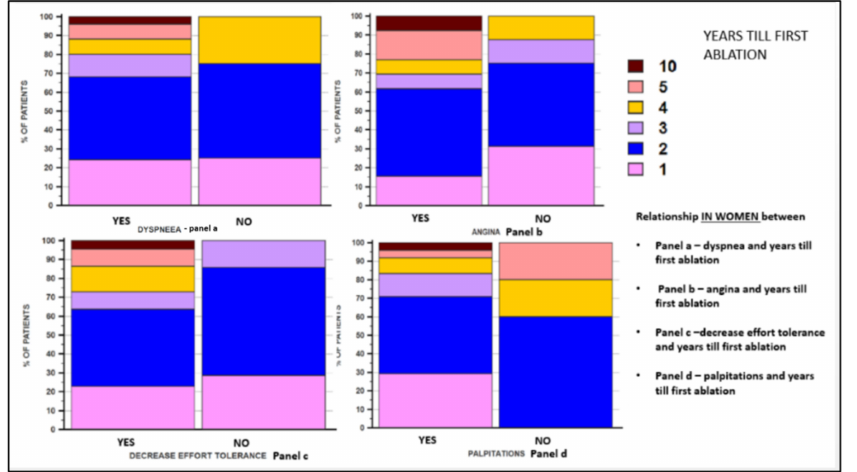
Figure 4. Correlation between the symptomatology of female patients and the number of years that passed until the ablation was performed.